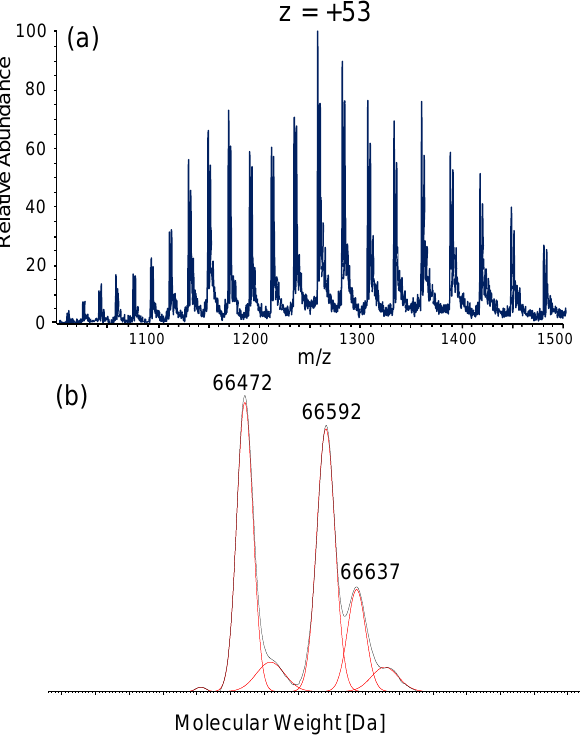
Figure 1. ESI-MS spectrum of intact HSA: ( a ) Multicharged ion profile of HSA. ( b ) Deconvoluted spectrum of HSA spectrum showing the mercaptoalbumin (HSA-SH) isoform at 66472 Da, the cysteinylated form, HSA-Cys, at 66592 Da (+120 Da with respect to HSA-SH) and the glycated form, HSA-gly, at 66637 Da (+165 Da).